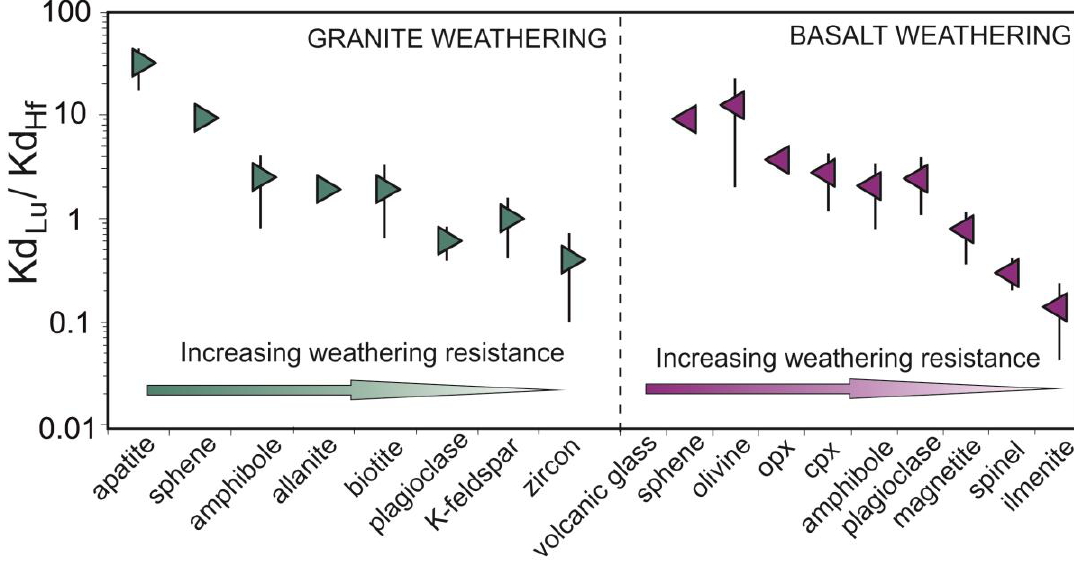
Figure 2. Partition coefficients (K d ) for Lu and Hf between melt and minerals in granitic and basaltic systems sorted after weathering resistance of individual minerals (adapted and slightly modified from [29]).